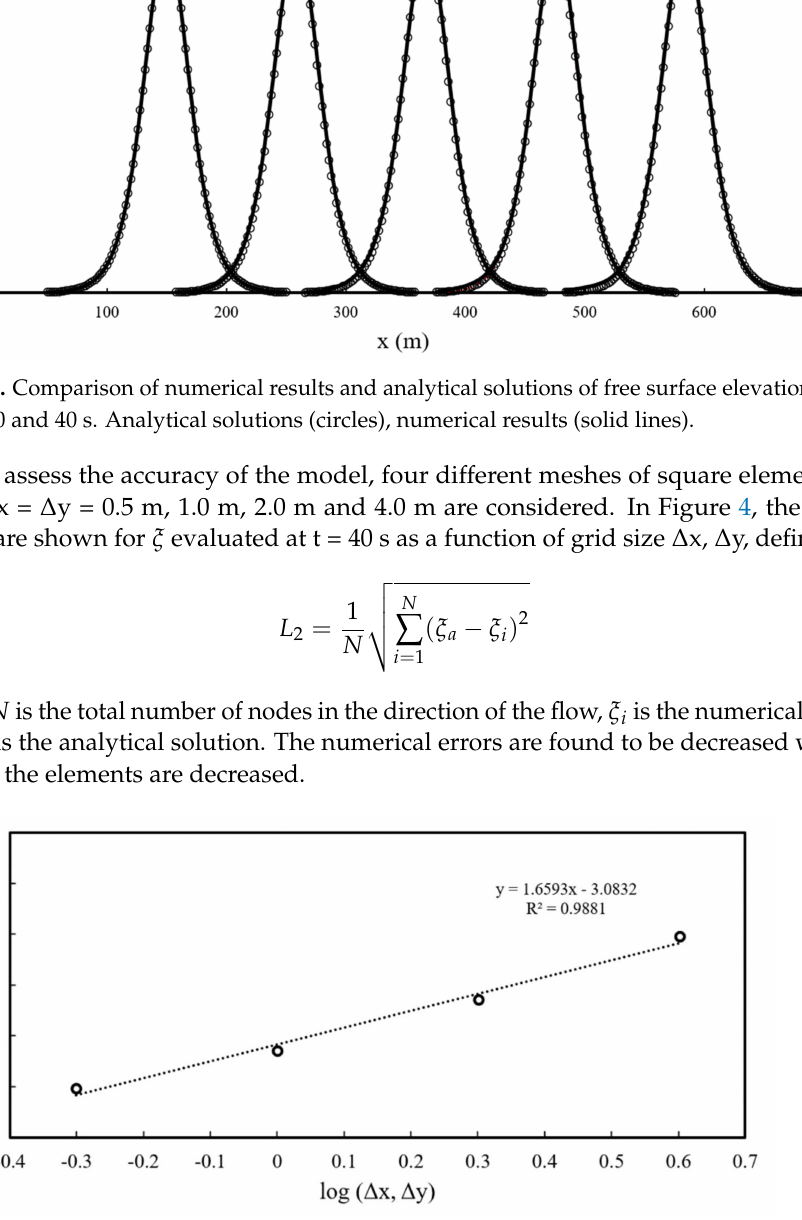
Figure 4. L 2 error norms for ξ as function of ∆ x, ∆ y for solitary wave propagation in constant